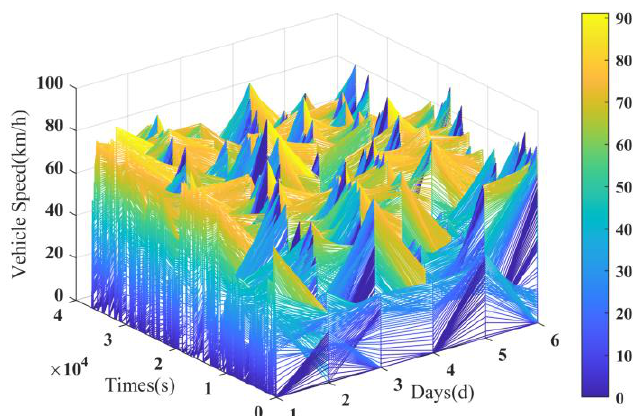
Figure 3. Driving speeds under the fixed route of six